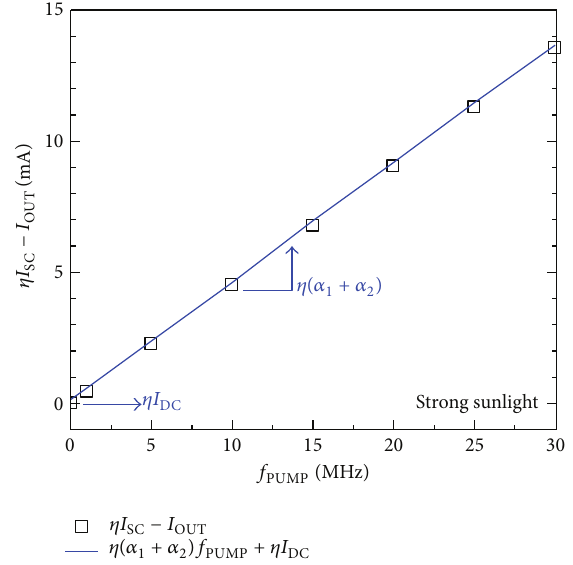
−𝐼 Figure 5: 𝜂𝐼 versus 𝜂(𝛼 1 +𝛼 2 )𝑓 SC OUT 𝑓 . The good agreement between 𝜂𝐼 PUMP )𝑓 + 𝜂𝐼 𝛼 indicates that (3) can describe the charge pump’s 2 PUMP DC output current driven by the solar cell